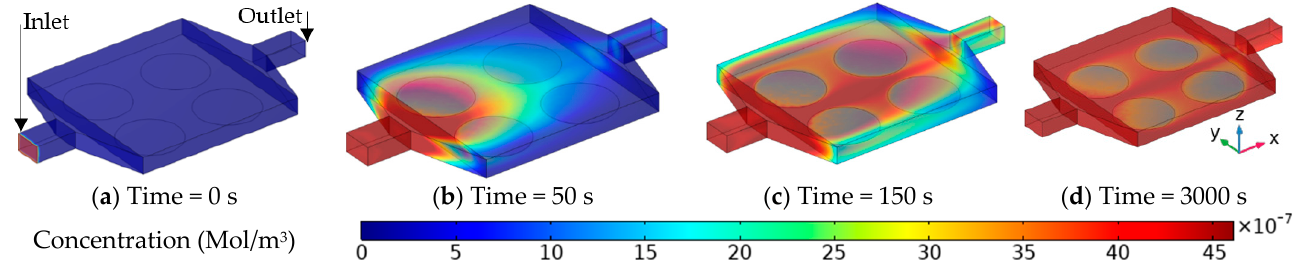
Figure 3. Concentration contour for the original case (A-01) at the start of the time ( a ), after 50 s ( b ), after 150 s ( c ), and at the end of 50 min ( d ).